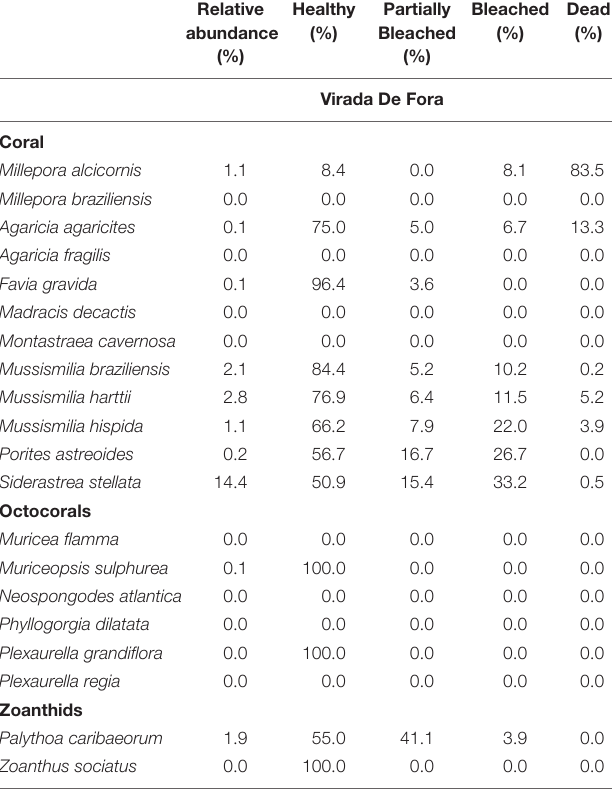
TABLE 2 | Average coral cover percentage, corals bleaching rates and mortality rates in Coroa Vermelha, Pedra do Silva, and Virada de Fora reefs, Abrolhos Region,